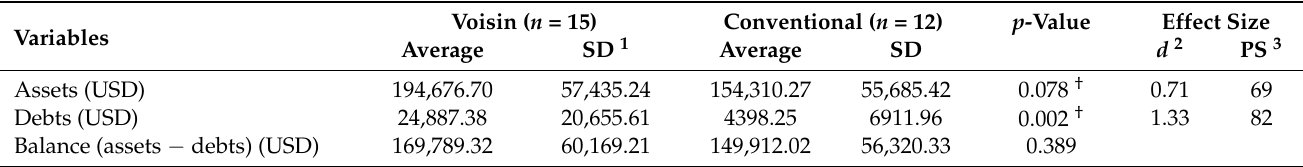
Table 8. Farm assets and debts.